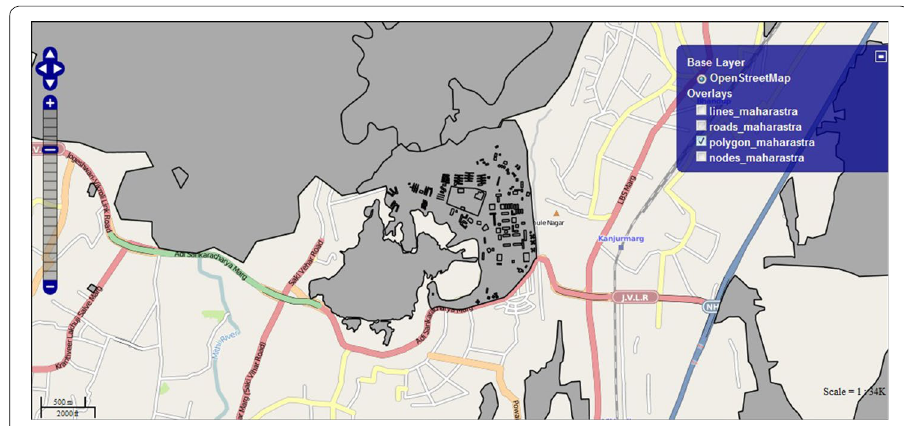
Fig. 11 Polygon features rendered over Open Street Maps